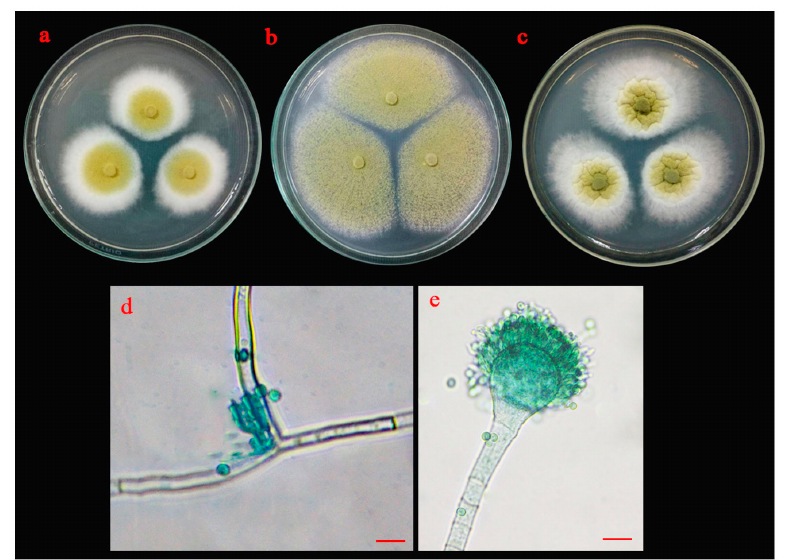
Fig. 6.(A). Morphological characteristics of UD01 isolate: colonies of UD01 isolate on three different media (a; PDA, b; MEA and c; CYA medium); sporangiophore with stolon (d) and conidia (e); the scale bar = 10